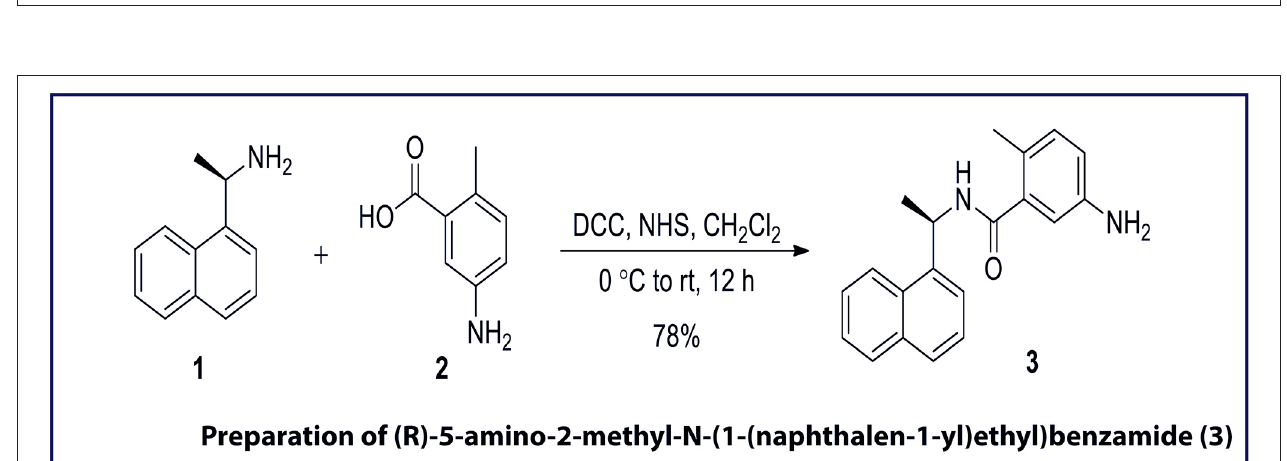
FIGURE 2 | Chemical synthesis of GRL0617 inhibitor, a known inhibitor of SARS-CoV-2 PLpro activity. DCC, N , N -dicyclohexylcarbodiimide; NHS, N -hydroxysuccinimide; rt, room temperature. The figure is self-explanatory; the reagents and reaction conditions, i.e., experimental procedure is already mentioned on the